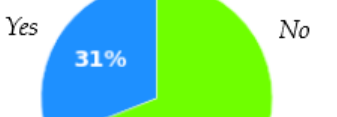
Figure 4. Answers for question of do you have any experiences on operating financial derivatives? Only 31% of the respondents had experience with holdings of cryptocurrencies, while the other 69% did not (Figure 5, Table A6).